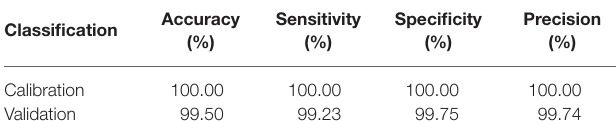
TABLE 1 | SVM model evaluation of feature variables.